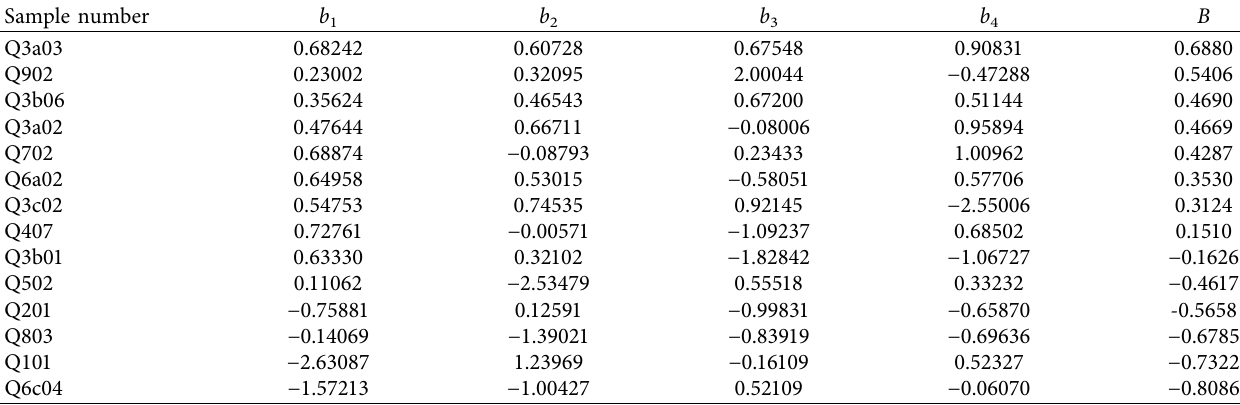
Table 7: Sample factors of incense burners in the Qing